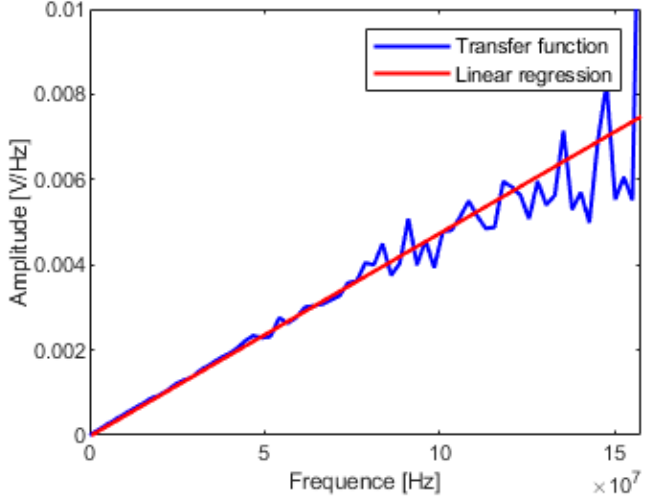
Figure 9. Partial linear regression of the FFT method.